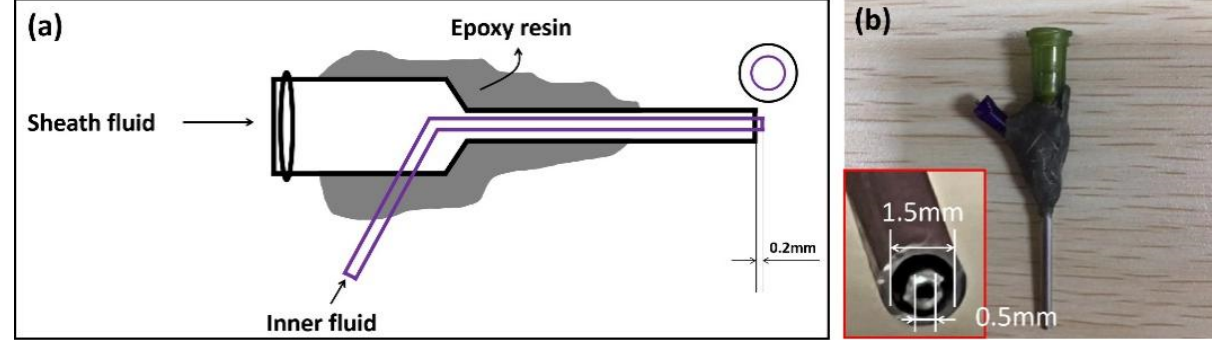
Figure 2 . Structure of homemade coaxial spinneret: ( a ) diagram of designed detail structure of the coaxial spinneret; ( b ) coaxial spinneret and the head of the spinneret (bottom-left insert).